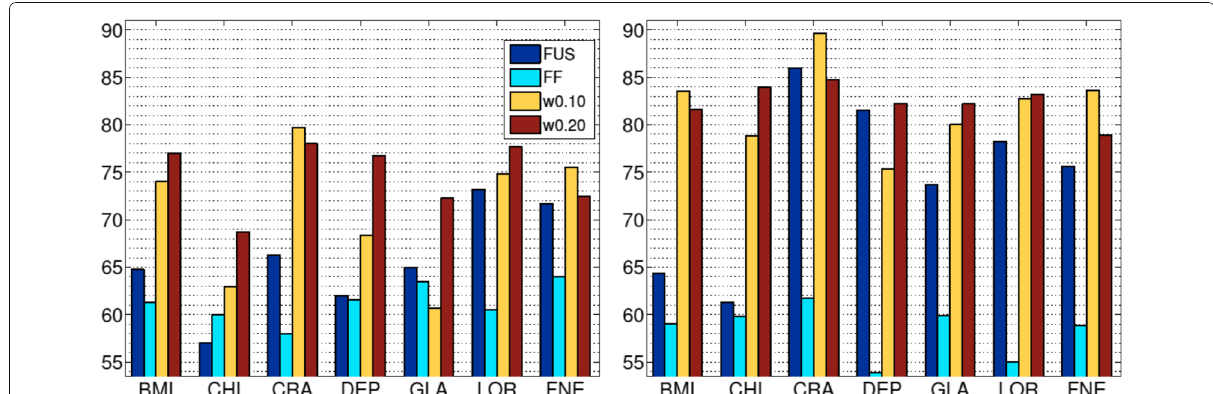
Fig. 15 Subjective evaluation results by 20 humans. Informativeness ( leftfigure ) and enjoyability ( rightfigure ) results of AVT summaries at ( × 5) rate were FUS that denotes the best summary obtained using fusion methods as presented in [12], FF denotes “fast-forward”, while the two newly produced summaries are differentiated by the weight used in the text